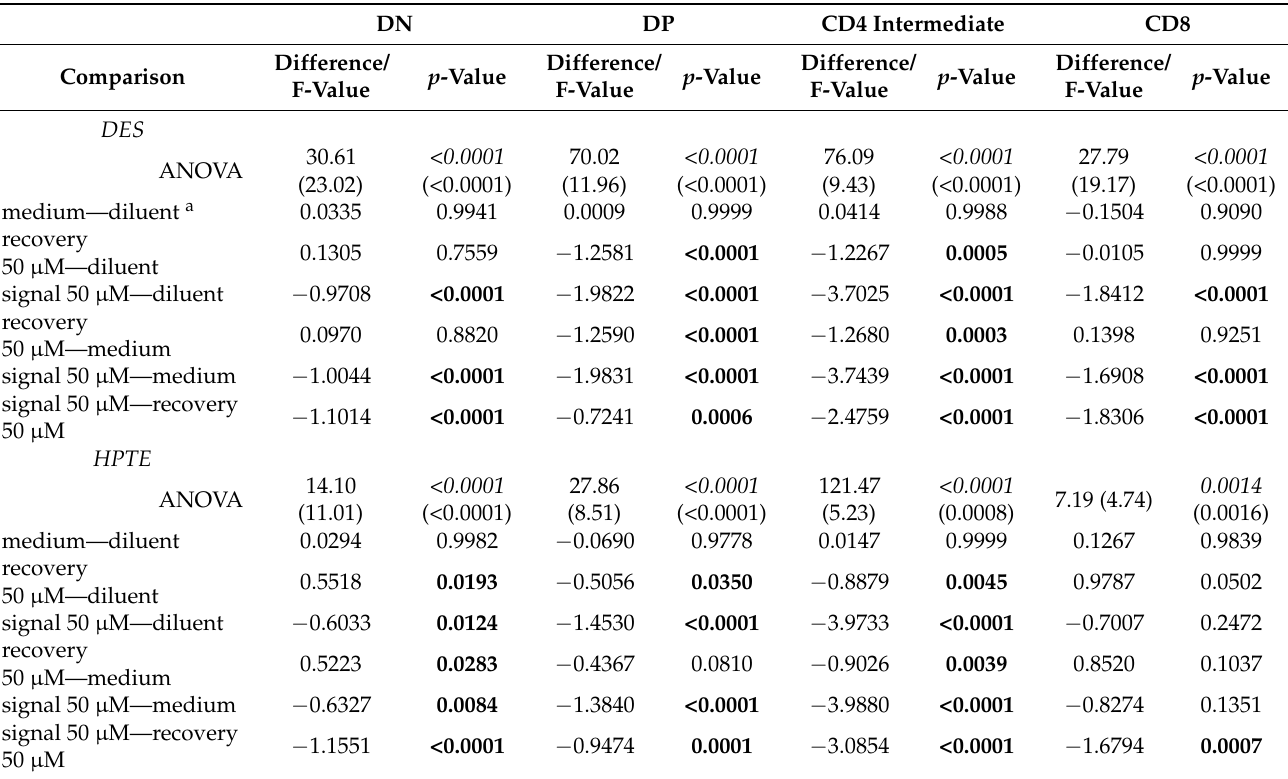
Table 3. Pairwise comparisons of thymocyte subpopulations exposed in recovery or signaling culture from Tukey HSD post hoc